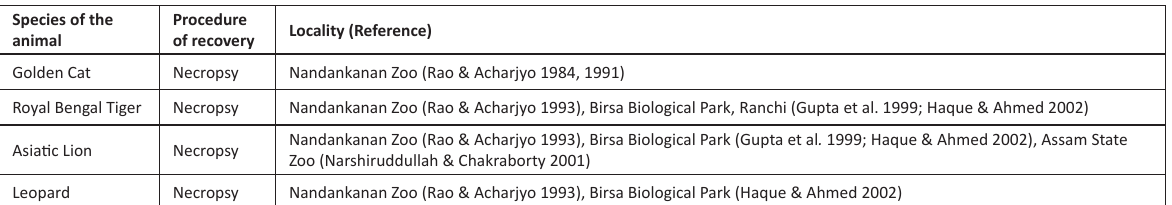
Table 4. Reports of D. immitis infections in wild felids Species of the animal